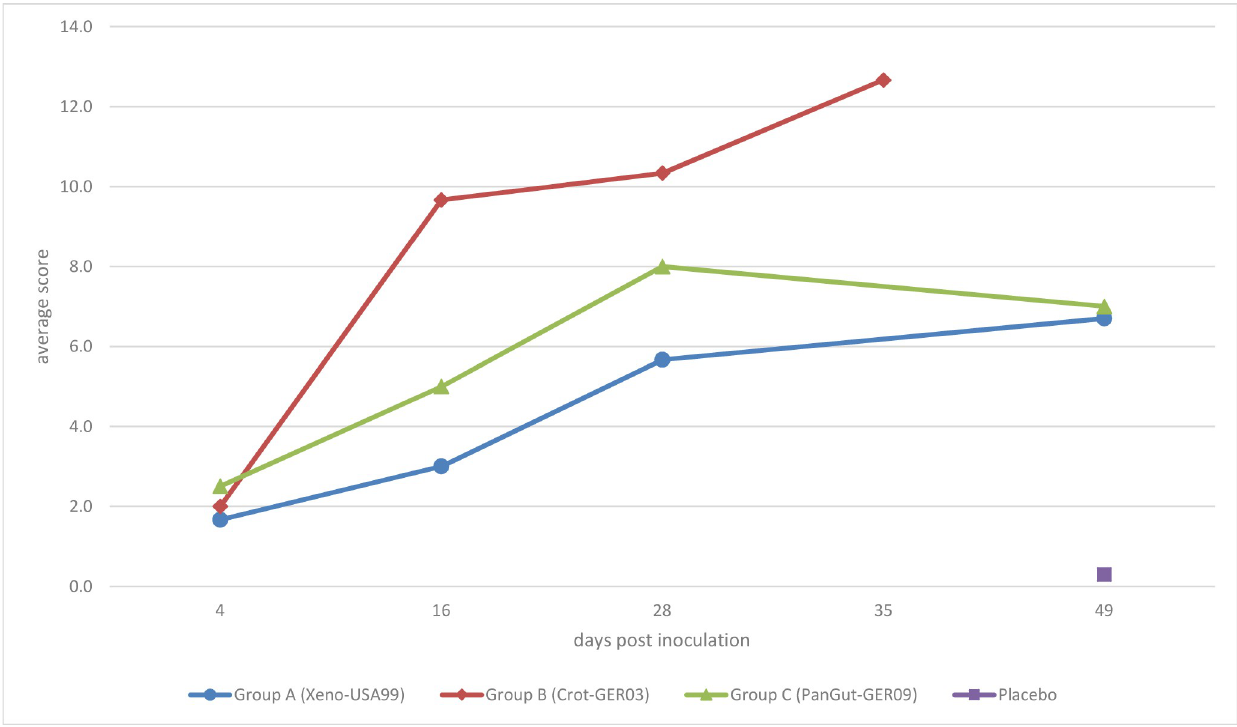
Fig 8. Evaluation scores after inoculation with a genogroup A, B or C ferlavirus strain. Each point is the average of the scores for all criteria for three animals that died by or were euthanized on the given day post inoculation (group C: day 4–4 snakes, day 16–2 snakes). Snakes in group B showed an earlier onset of pathological findiungs and a more dramatic course of disease, resulting in an early end of the study on day 35 post infection.